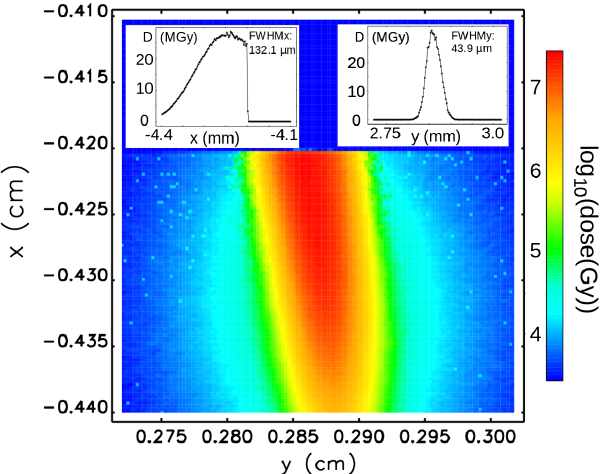
FIG. 11. Horizontal collimator assembly plan view. The colli- mator test pieces are stacked in the y direction so that only one is visible in this view; in addition, the collimator pieces are shown fully inserted, past the centerline. In the experiments, the collimators are withdrawn to a parking position allowing the beam to circulate. Dimensions are given in